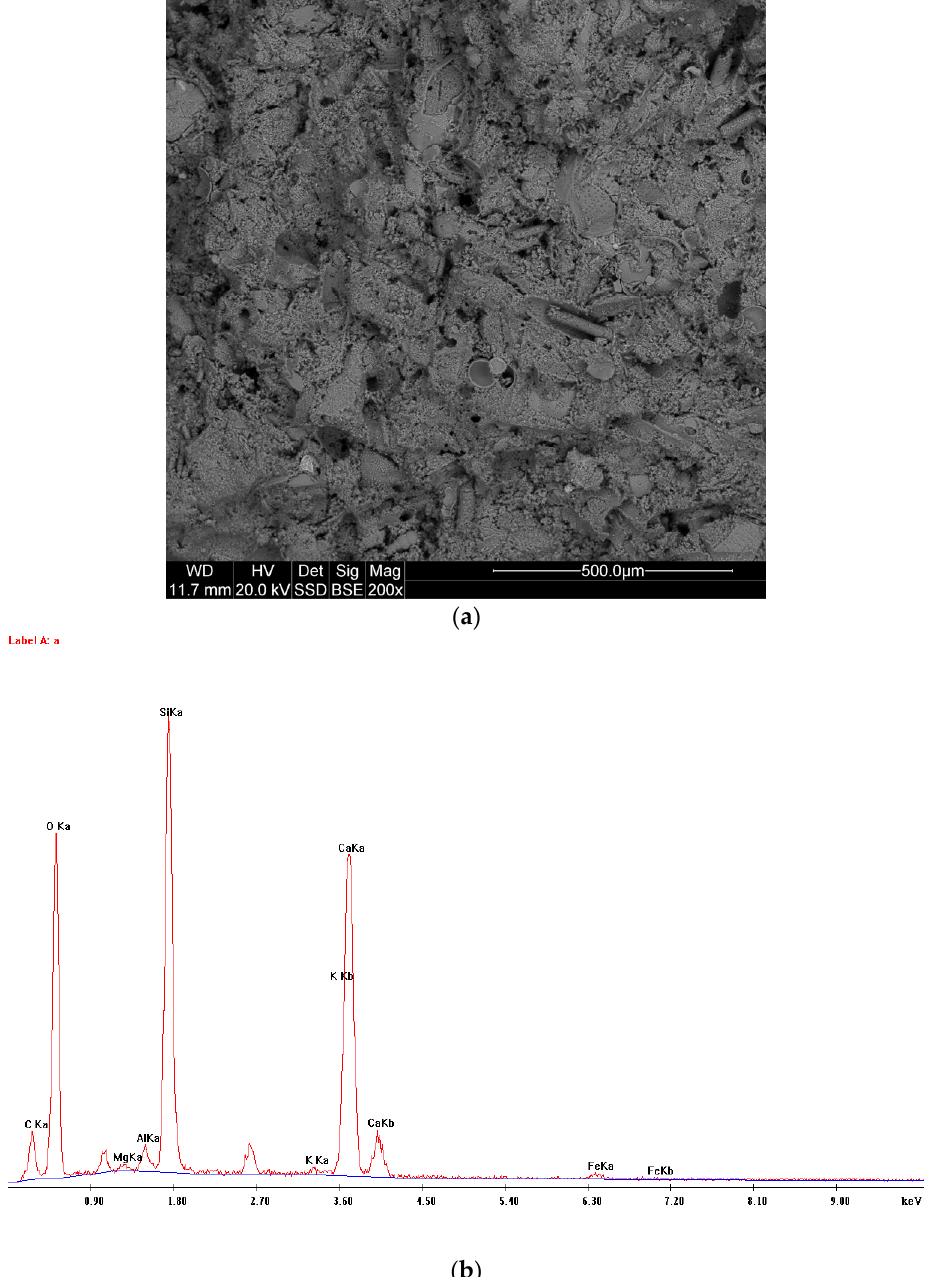
Figure 6. ( a ) The silica-carbonate structure of the opoka rocks under electron-microscope imaging (SEM). SEM—scanning electron microscopy. ( b ) Analyses of the chemical composition of the samples (EDX). EDX—electron microscope equipped with an X-ray spectrometer.